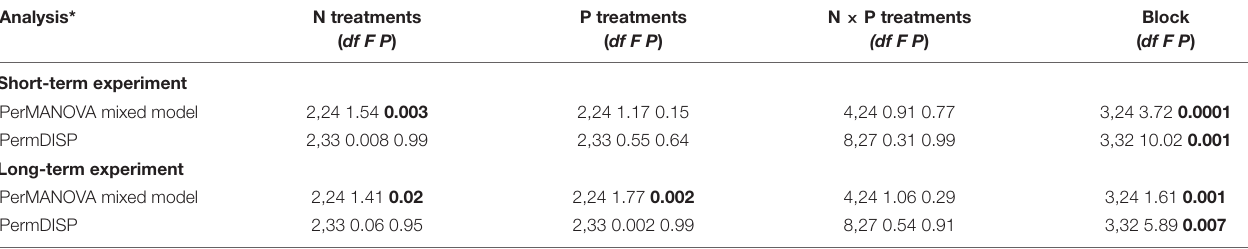
TABLE 1 | PerMANOVA results of fungal community composition in response to different N and/or P addition treatments.